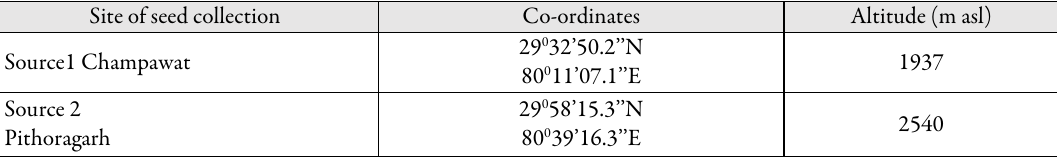
Table 1. Geographical locations and altitudes of the two seed sources of Pyrus